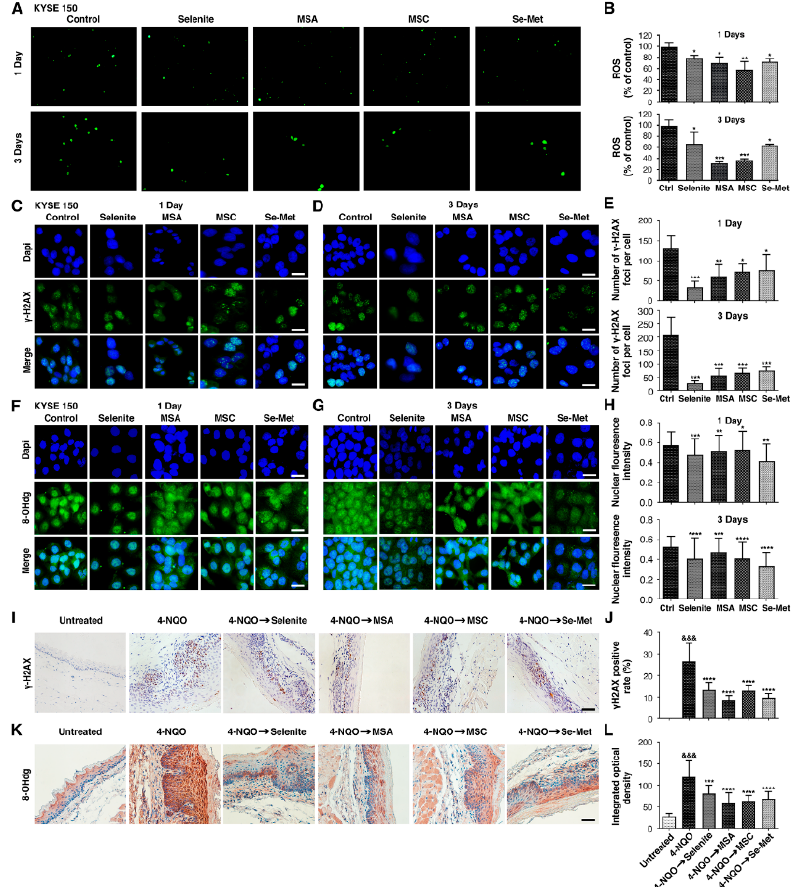
Figure 5. Selenium diminishes intracellular ROS levels and oxidative DNA damage in ESCC. Cells were treated with selenite—(6 µM), MSA (2 µM), MSC (100 µM), and Se-Met (100 µM)—for 1 and 3 days. ( A ) The level of intracellular ROS in KYSE 150 cells was stained by DCFH-DA and observed under Zeiss Vert A1 fluorescence microscope. ( B ) Statistical results were read by fluorescent plate reader in KYSE 150 cells. γ -H2AX expression and 8-OHdg expression were visualized by immunofluorescence using primary specific antibodies and Alexa Fluor 488-conjugated secondary antibodies. Nuclei were stained with DAPI. ( C , D ) Representative images of γ H2AX immunostaining after 1 day and 3 days in KYSE 150. ( E ) Columns represent the number of γ -H2AX foci/cell for each treatment after 1 day and 3 days in KYSE 150. ( F , G ) Representative images of 8-OHdg immunostaining after 1 day and 3 days in KYSE 150. ( H ). Histograms show nuclear fluorescence intensity signal quantification in the nuclei of each treatment after 1 day and 3 days in KYSE 150. Differences are significant at (* p < 0.05, ** p < 0.01, *** p < 0.001, **** p < 0.0001 vs. untreated control, n ≥ 3). Data are expressed as mean ± SD from three ( n = 3) independent experiments. (Magnification, ×40; scale bar = 20 µm.) Selenium compounds, selenite (0.05 mg/kg), MSA (0.05 mg/kg), MSC (0.1 mg/kg), and Se-Met (0.1 mg/kg) were administered for 4 weeks of post-completion and 16 weeks for 4-NQO exposure. The mice were sacrificed, and the esophagus sections were fixed, embedded in paraffin, and sectioned. Then, the tissue sections were stained with γ -H2AX and 8-OHdg antibodies. Four to five representative areas of each esophagus section from each mouse per group were photographed and analyzed. ( I ) Immunohistochemical staining of γ -H2AX for each treatment group. ( J ) Statistical analysis of γ -H2AX-positive cells for each treatment group. ( K ) Fluorescence microscopy images of 8-OHdg immunostaining for each treatment group. ( L ) Statistical analysis of IOD of 8-OHdg immunostaining for each treatment group. Differences are significant at ( &&& p < 0.001 vs. untreated group, *** p < 0.001, **** p < 0.0001 vs. 4-NQO group). The difference with p ≤ 0.05 was considered statistically significant. (Magnification, ×400; scale bar = 40 µm.)